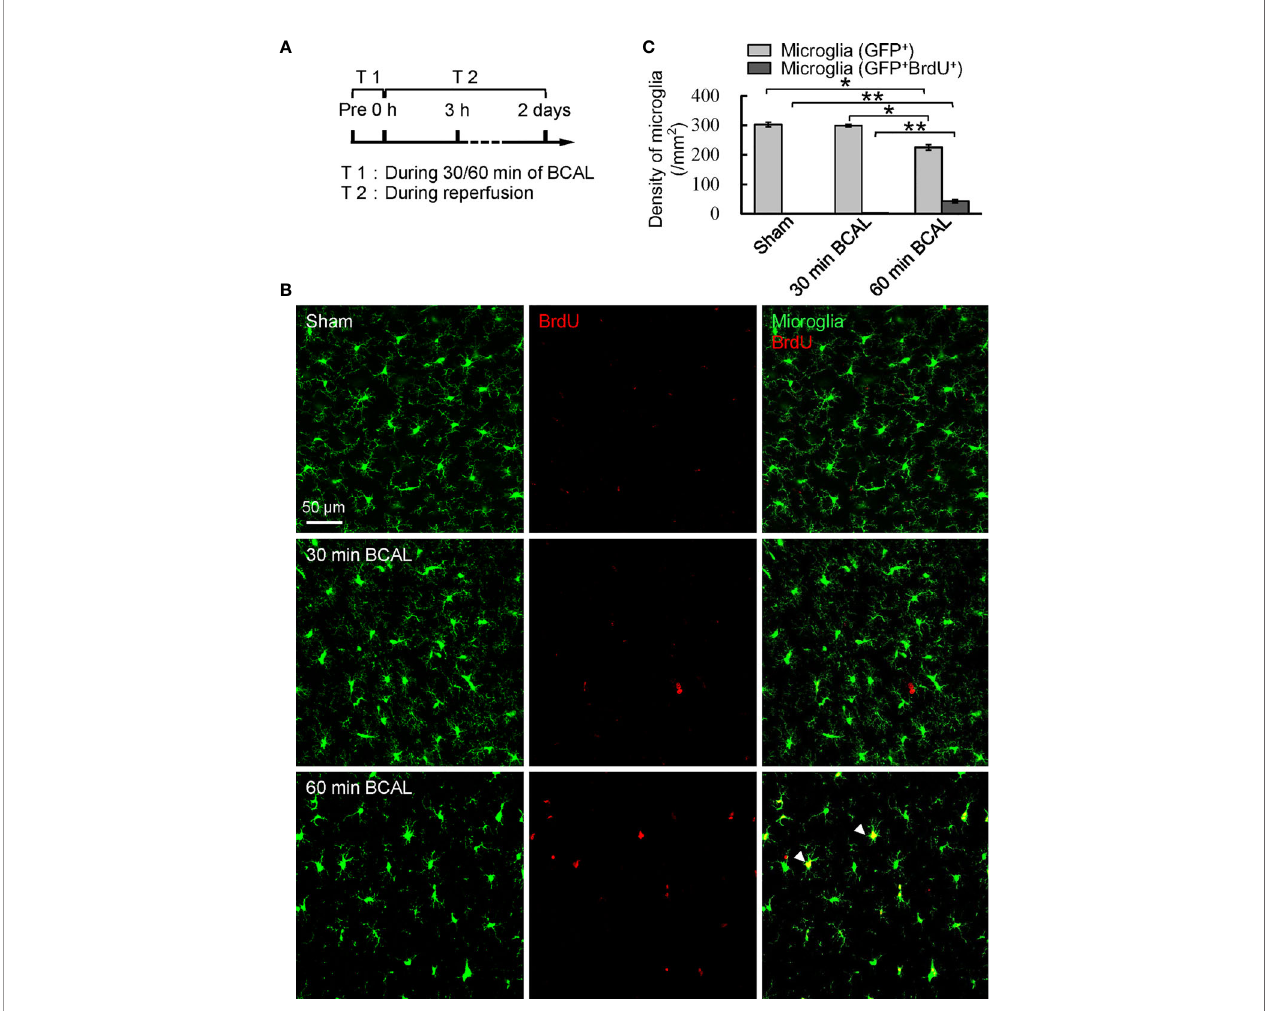
FIGURE 1 | Effect of different degree of ischemia on microglial density and proliferation. (A) Timeline showing the time points for ischemia, reperfusion, and measuring microglial density and proliferation. (B) Confocal images show microglia (green) and BrdU labeled cells (red) in Sham, 30 min BCAL, and 60 min BCAL group. Arrowheads indicate GFP + /BrdU + cells that were identi fi ed as proliferative microglia. (C) Statistical plot showing the densities of GFP + and GFP + /BrdU + cells in Sham, 30 min BCAL and 60 min BCAL group (n = 6 for each group, * p <0.05, ** p